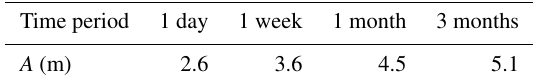
Table 2. Predicted internal wave heights in the Mediterranean